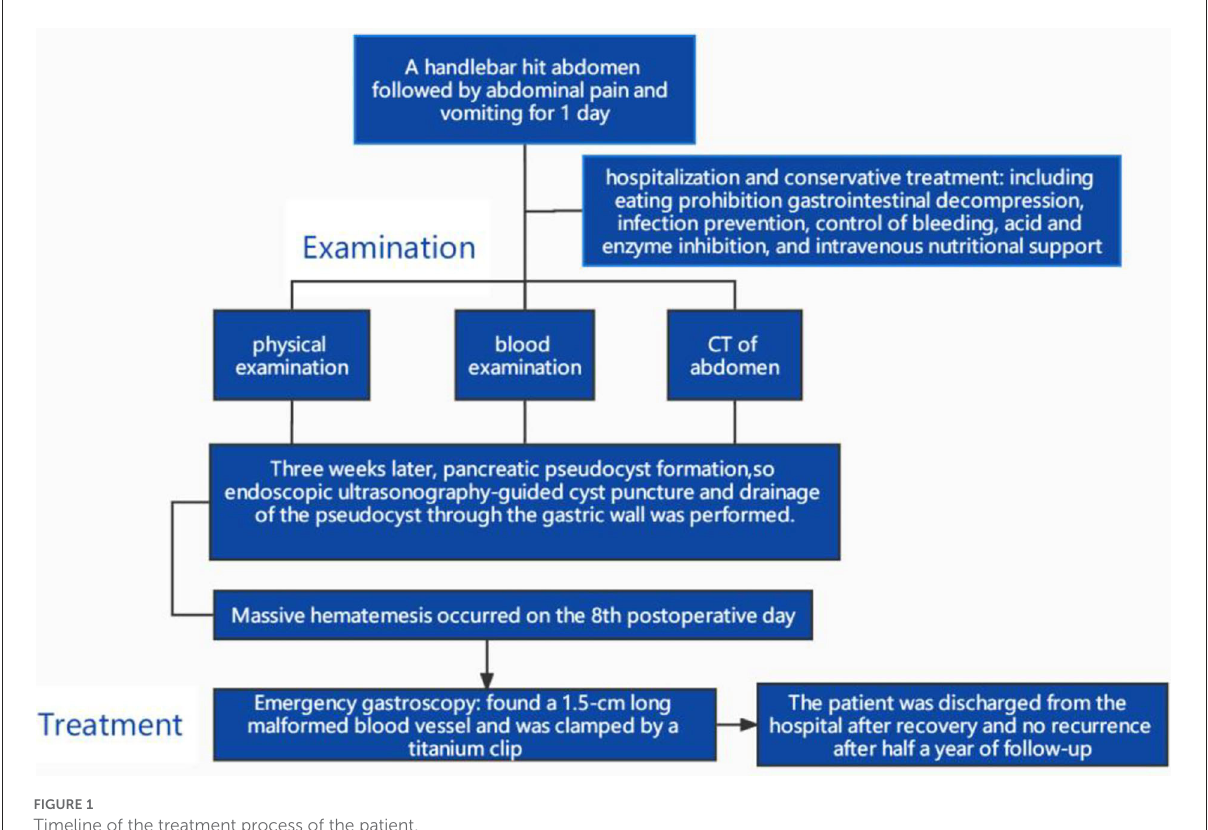
FIGURE1 Timeline of the treatment process of the